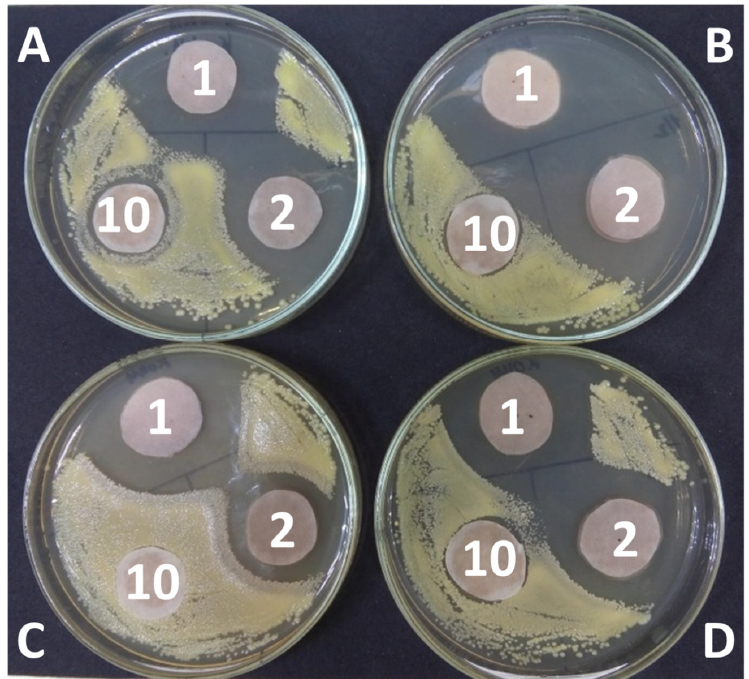
Figure 8. Experiment with Pseudomonas fluorescens and extracts at initial concentration and diluted 2 and 10 times. ( A )—NADES with malonic acid, ( B )—with malic acid, ( C )—with tartaric acid, and ( D )—with citric acid.